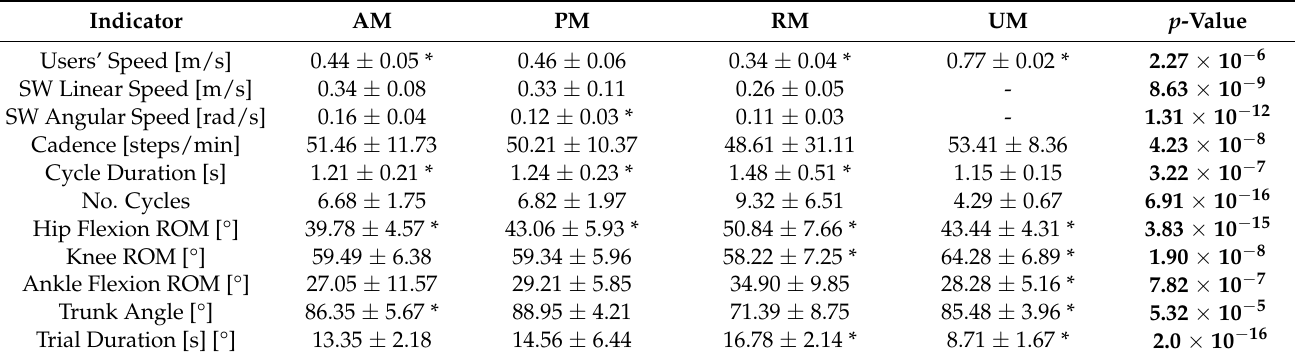
Table 5. Summary of kinematic and additional outcomes during